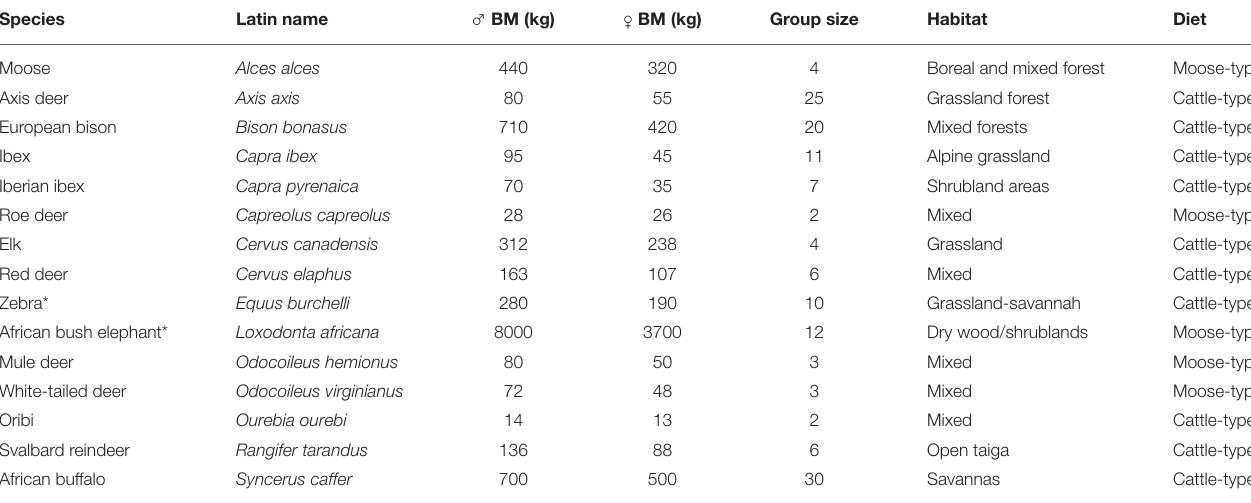
TABLE 2 | Characteristics of the species included in the 33 selected papers (productive and non-productive seasons).